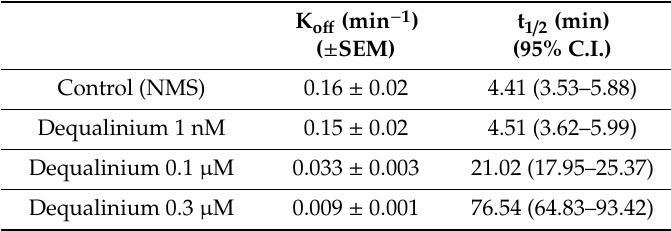
Table 6. Reduction of the dissociation rate (K o ff ) and the corresponding t 1 / 2 values of dissociation as obtained from full time course experiments at three di ff erent concentrations and during a monitored time of 160